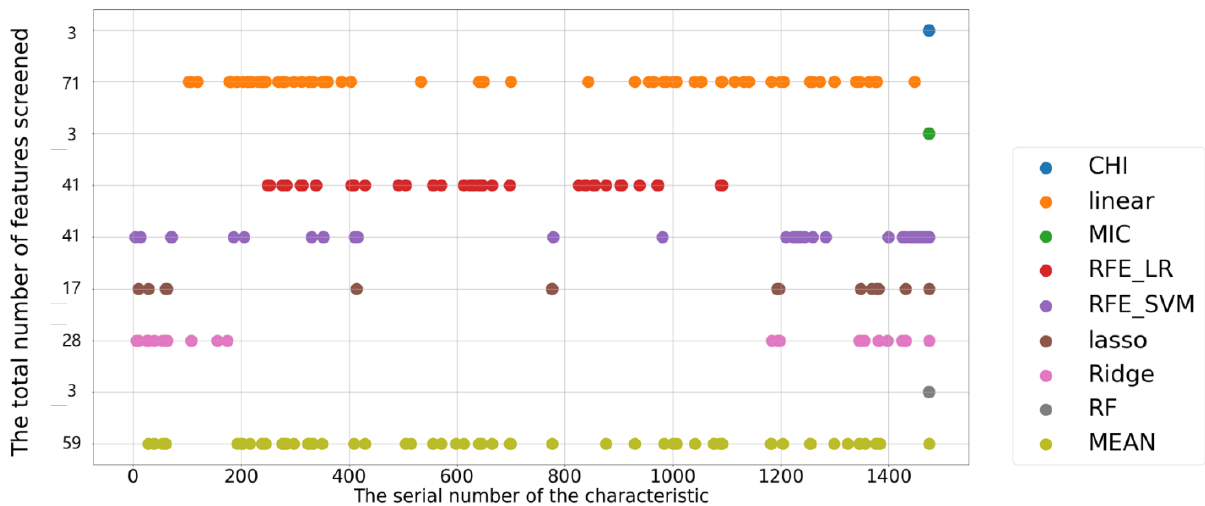
Figure 12. Feature selection results based on multi-source data.